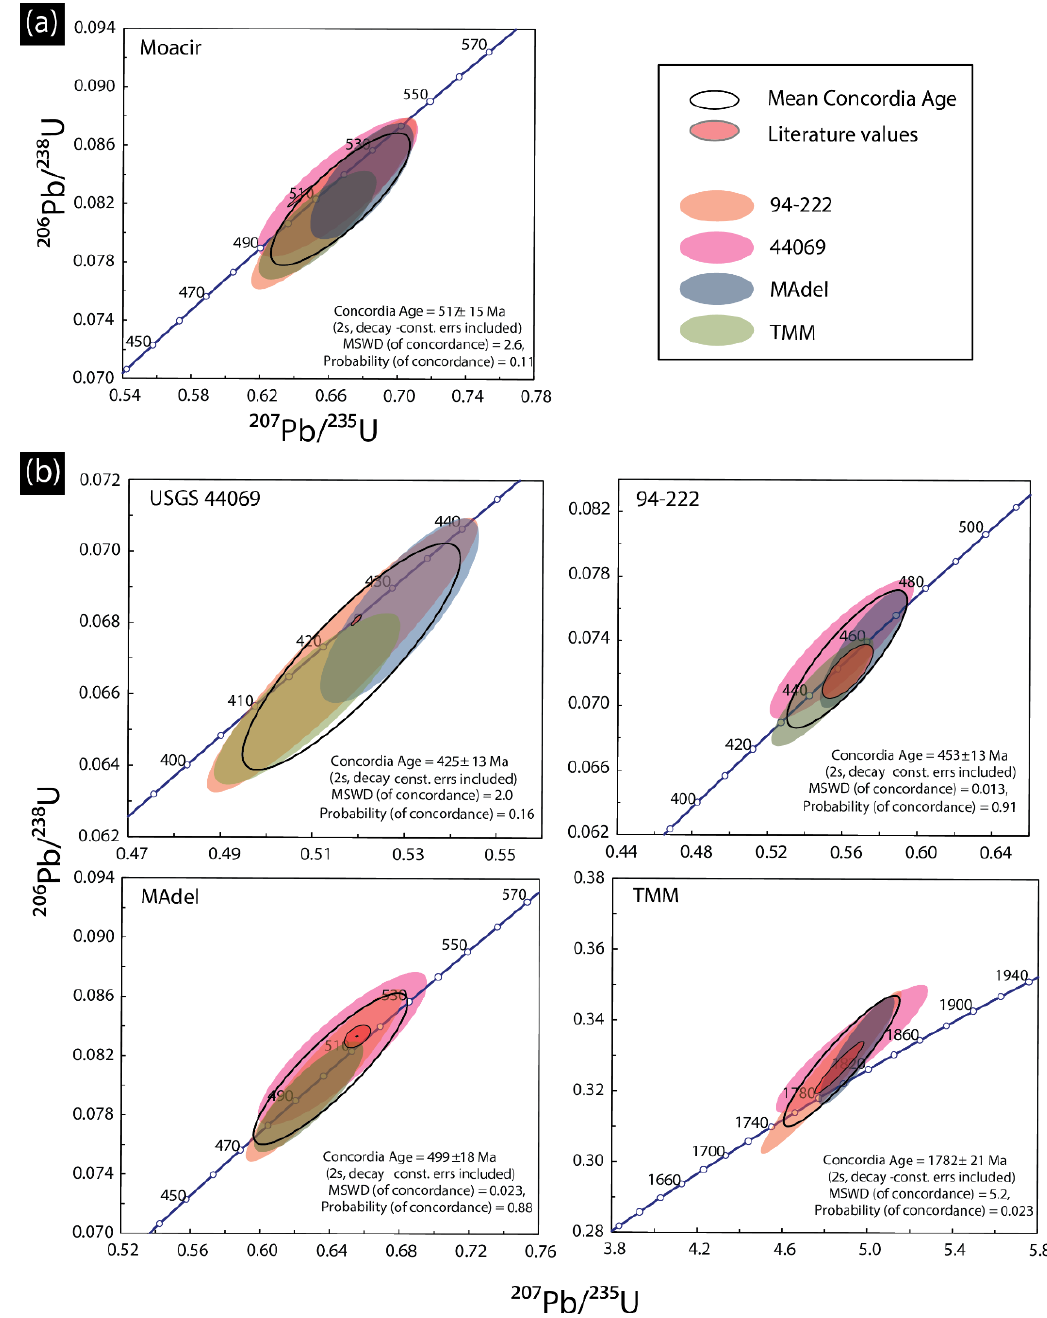
Figure 6. Accuracy plots after [71] . The data (Table S4) for this calculation were used from the analytical session 130115. Each ellipse represents the age of monazite as standardized with a different monazite. For example, the orange ellipse in the USGS 44069 accuracy concordia plot represents the age of USGS 44069 normalized to 94-222. The given concordia age results from all ellipses plotted in the graph. The ellipses represent 2s uncertainty. The red data ellipse shows the literature value. ( a ) Accuracy plot for Moacir (n = 10) shows that the mean concordia age does not overlap with the literature value. Due to this, we excluded Moacir from all other plots, because the accuracy and precision would be reduced for the tested RMs. ( b ) Accuracy plots for monazite reference sample USGS 44069 (n = 12), 94-222 (n = 14), MAdel (n = 10) and TMM (n = 9).